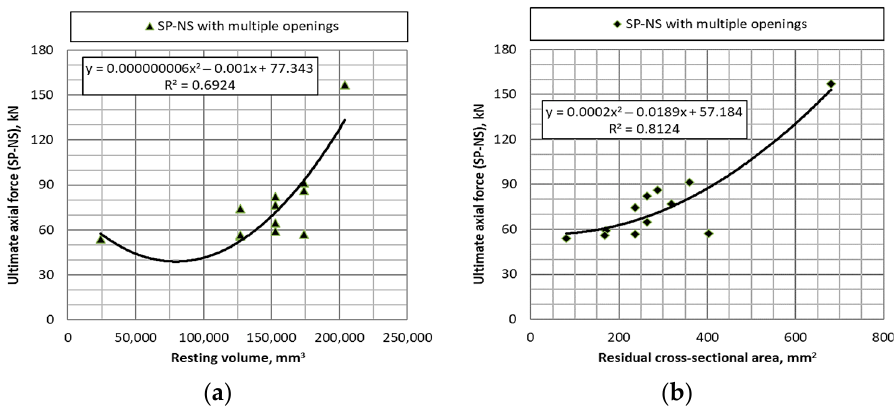
Figure 17. Ultimate axial force as a function of resting volume ( a ) and residual cross-sectional area ( b ).